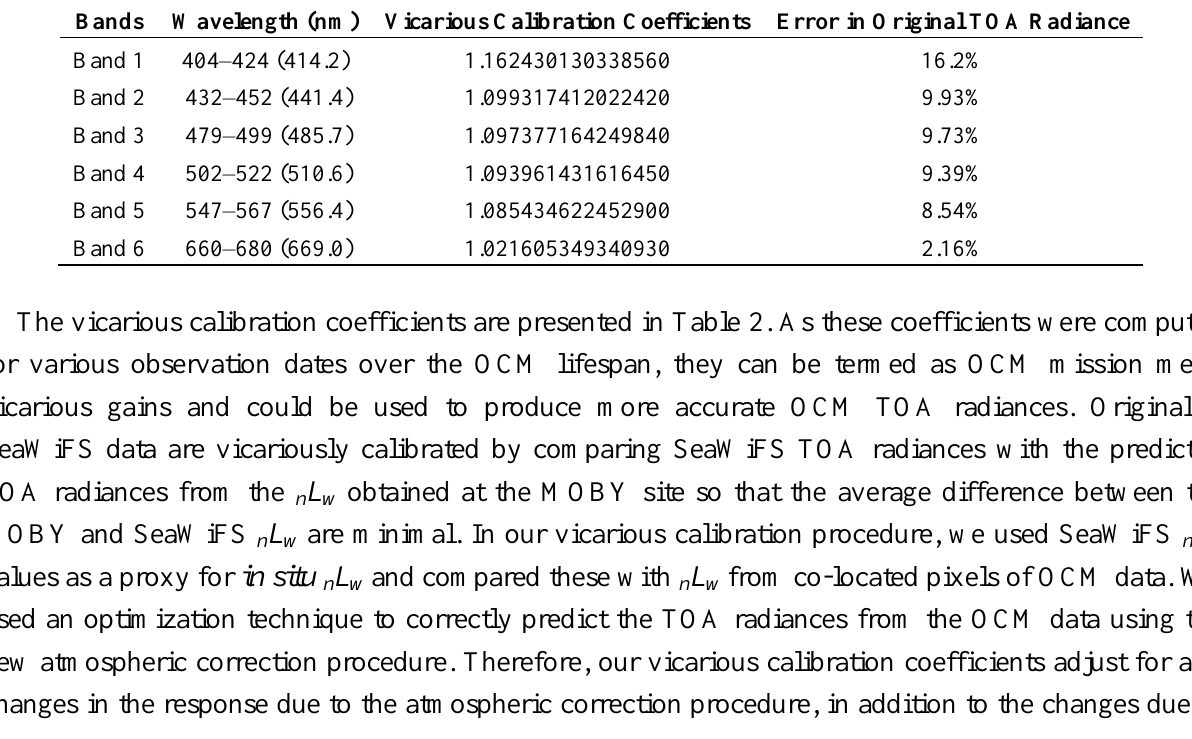
Table 2. Vicarious calibration coefficients of OCM bands